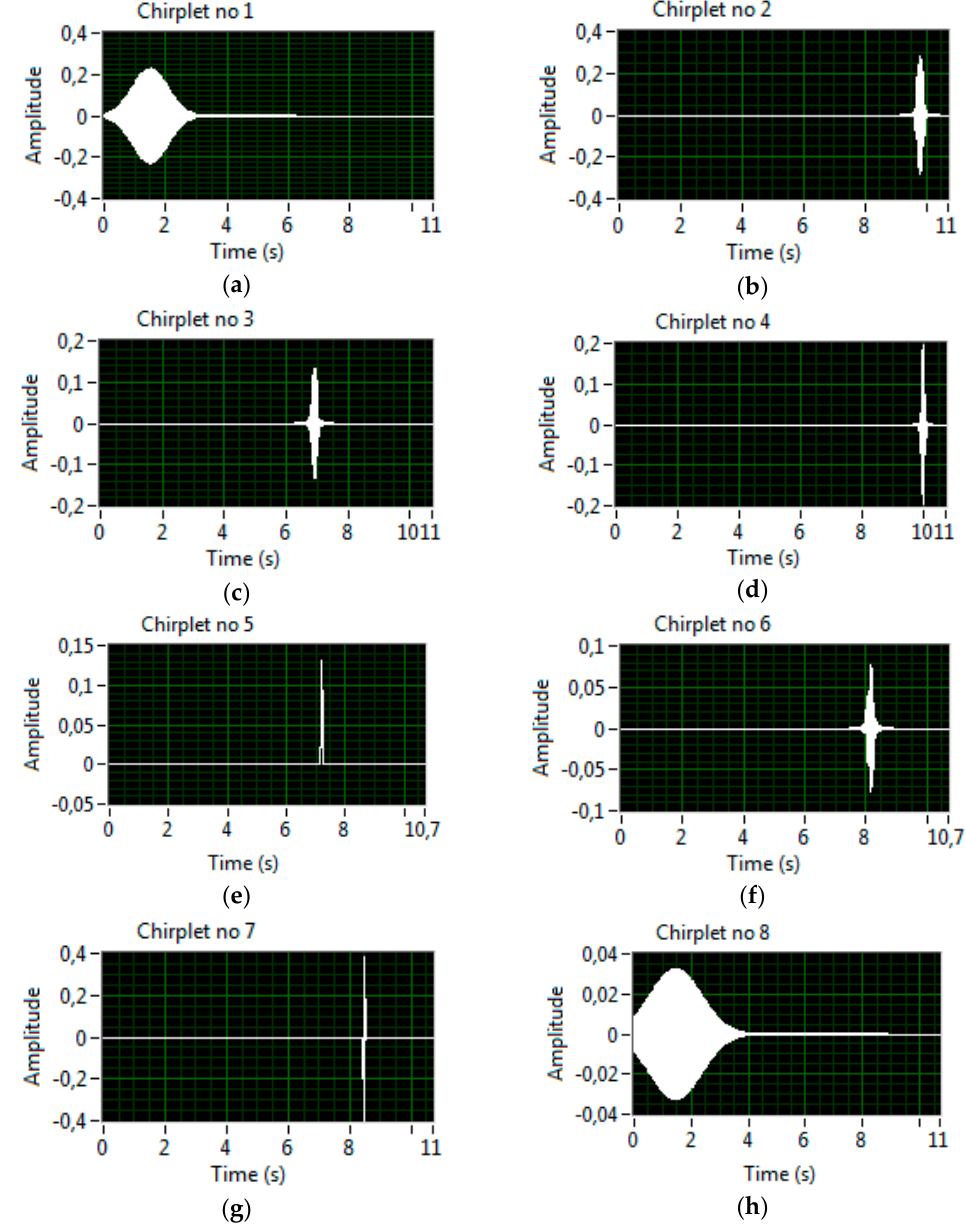
Figure 8. The time waveforms of the components of reconstructed signal representing chirlpet atoms described in Table 1: ( a ) chirplet no 1; ( b ) chirplet no 2; ( c ) chirplet no 3; ( d ) chirplet no 4; ( e ) chirplet no 5; ( f ) chirplet no 6; ( g ) chirplet no 7; and ( h ) chirplet no